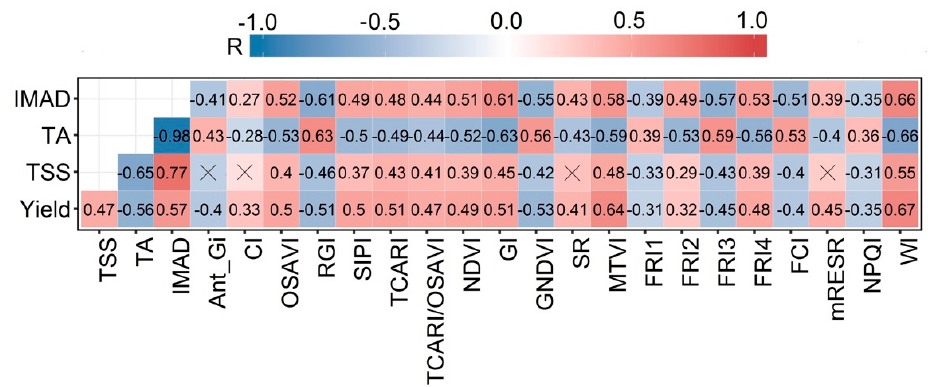
Figure 5. Correlogram of Spearman correlation coefficients found between vine berry yield/quality parameters and hyperspectral indices. Crosses indicate relationships that are not significant when p -values ≤ 0.05.